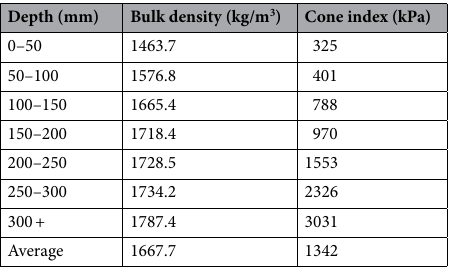
Table 1. Soil physical properties measured at the soil bin.